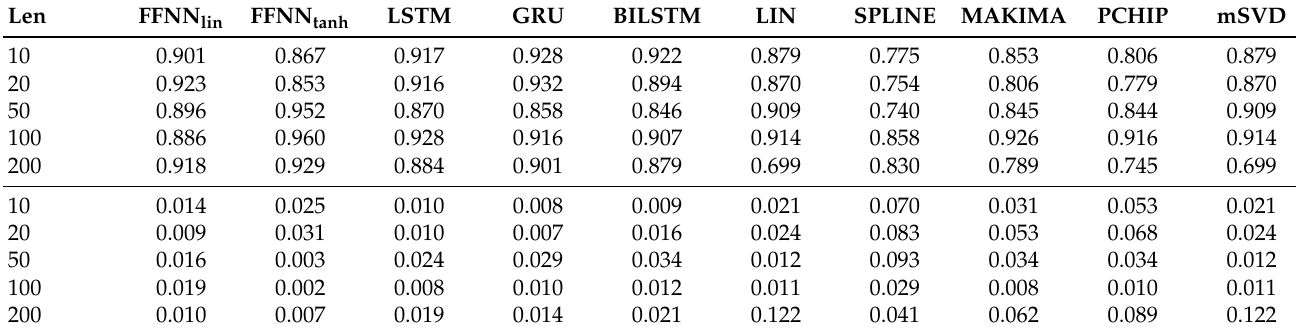
Table A9. Correlation between RMSE and acceleration of input sequence.